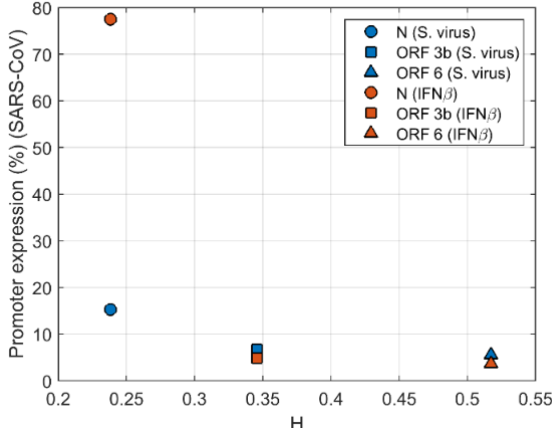
Figure 8. The SARS-CoV escapes innate immunity by suppressing ISRE (indicating interferon syn- thesis) promoter expression through ORFs encoding accessory proteins. The expression of ISRE- promoter decays rapidly (15.2%, 6.7% 5.6% for S. virus, 77.5%, 4.9%, 3.6% for IFN- β ) along with the increasing HGS values.